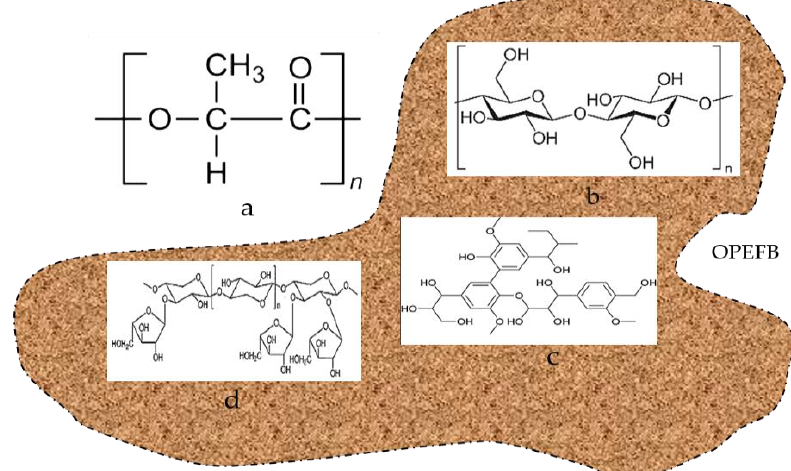
Figure 1. Chemical structure of ( a ) polylactic acid (PLA) and chemical structure of oil palm empty fruit bunch (OPEFB) fiber content include ( b ) cellulose, ( c ) hemicelluloses, and ( c ) lignin.